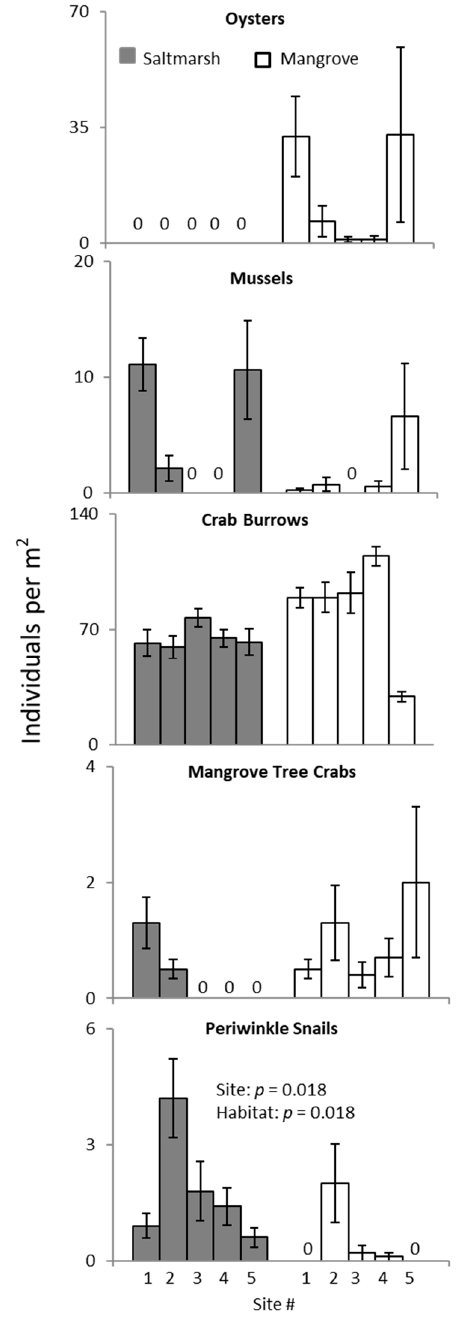
Figure 6. Invertebrate densities across saltmarsh (dark grey) and mangrove (white) sites along the ecotone. Significant results are displayed in the inset panel. Data are shown as the mean ± SEM for five replicate survey plots per site.